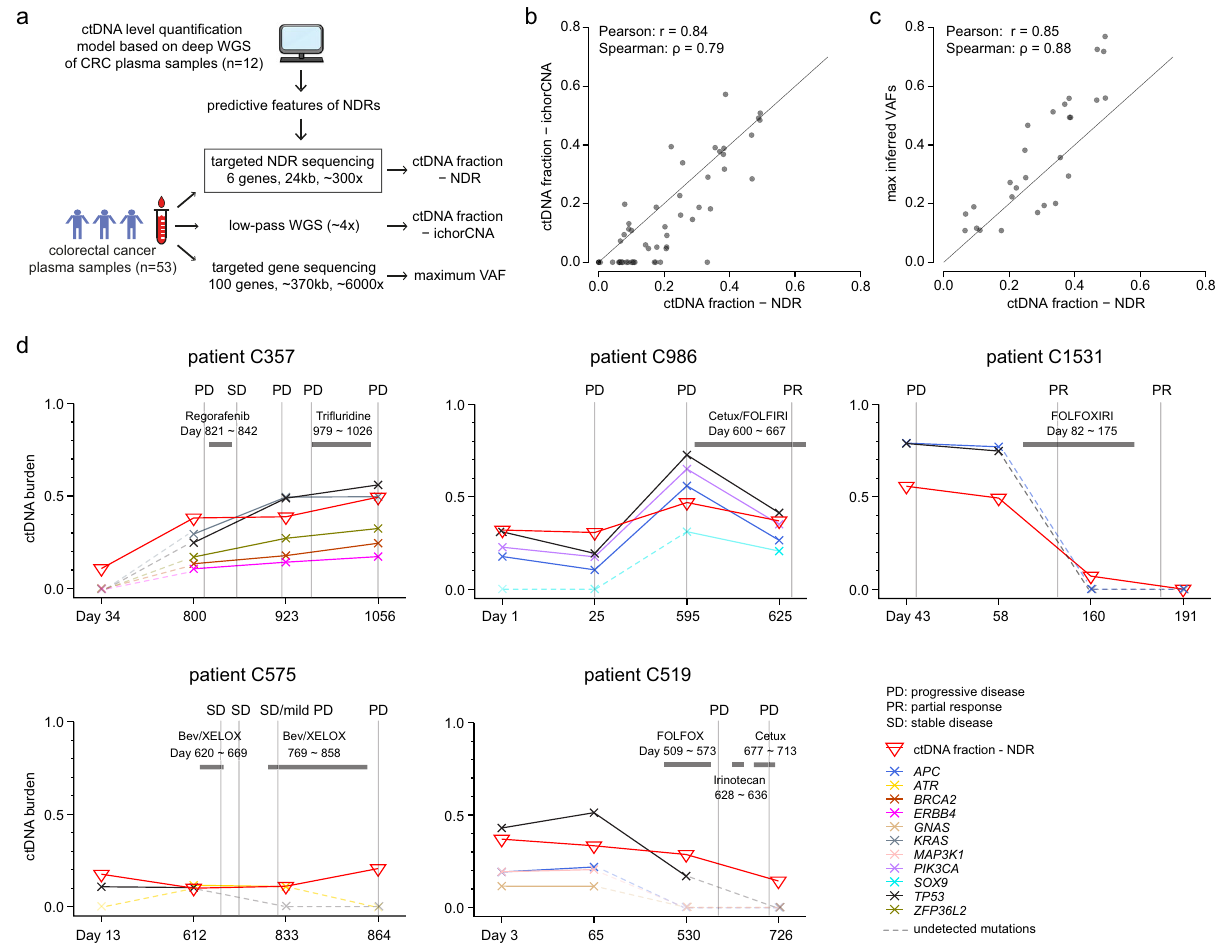
Fig. 4 Targeted NDR assay to quantify ctDNA burden and monitor cancer progression. a Schematic showing how targeted NDR sequencing, low-pass WGS, and targeted gene sequencing were performed on a cohort of 53 CRC plasma samples. b Comparison of ctDNA fractions ( n = 53) inferred by targeted NDR sequencing and low-pass WGS (ichorCNA). c Comparison of ctDNA fractions ( n = 27) inferred by targeted NDR sequencing and maximum VAFs (maximum VAF of all SNVs identi fi ed in a given plasma sample). d NDR-quanti fi ed ctDNA burden across serial plasma samples and its association with events of cancer progression and treatment response. Somatic SNV VAFs are highlighted for each timepoint; SNVs detected in at least two timepoints are shown. SNVs undetected with standard fi ltering criteria at given timepoints are indicated with a dashed line. Treatment types and intervals are highlighted. Events of disease progression as inferred by computerized tomography (CT) scans are samples/timepoints from the same patients, the raw sequencing